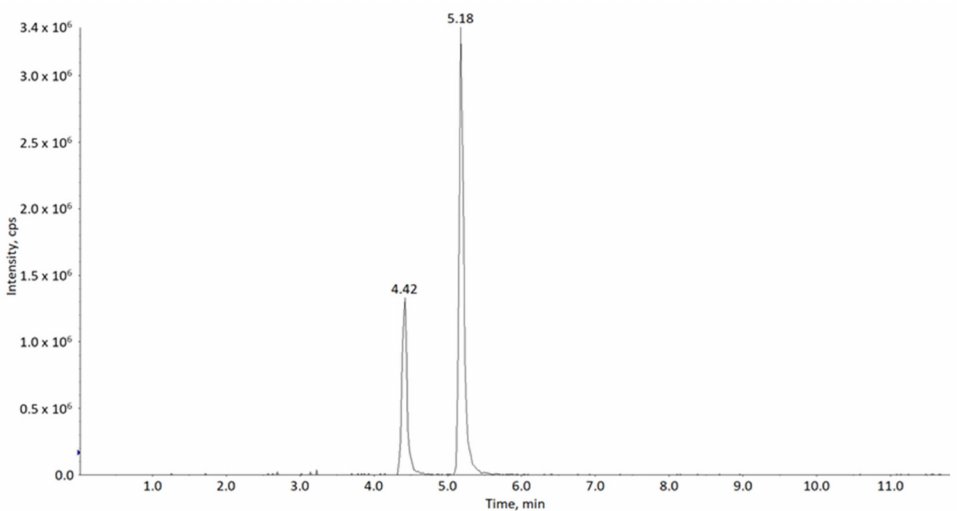
Figure 3. Incubation of 3,4-dideoxyglucosone-3-ene (3,4-DGE) with L -glutathione (GSH) results in two products with a m/z value of 524.3 Da. Total ion chromatogram of an enhanced product ion scan (EPI) for the m/z value of 524.3 Da for the model solution containing 165.0 µ M 3,4-DGE and 91.0 µ M GSH after incubation at 37 ◦ C for 1 h after derivatization with ortho -phenylenediamine ( o